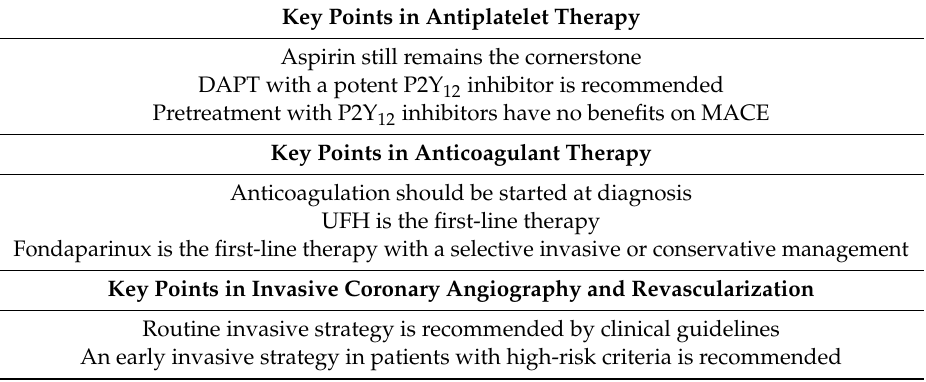
Table 2. Key points in antithrombotic pretreatment and invasive strategies in NSTE-ACS. Key Points in Antiplatelet Therapy Aspirin still remains the